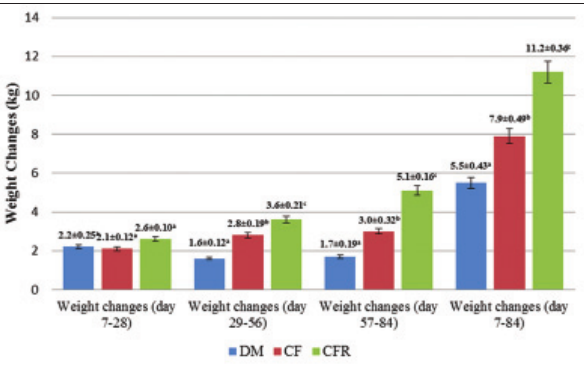
Figure-1: Weight changes of experimental kids from dams’ milk, creep feed and creep feed containing alfalfa treatment groups at different age periods Values in the figures were means±standard error of each treatment group (n=16). Different superscripts above the bars in each age period significantly differ